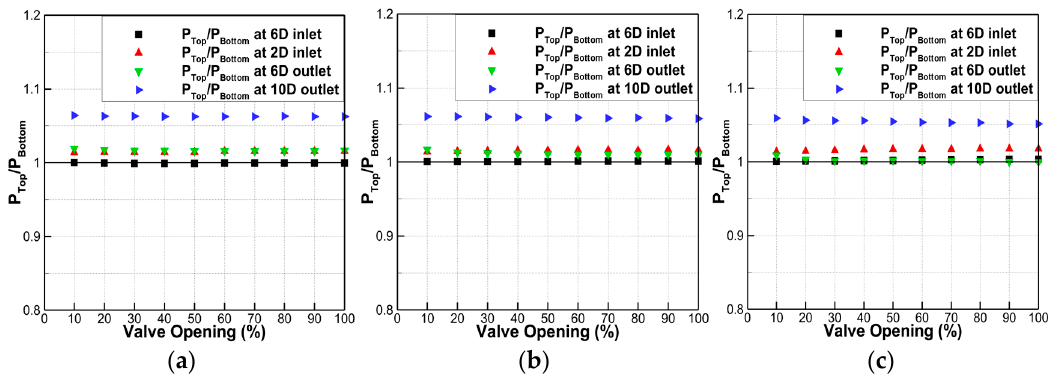
Figure 8. Comparison of pressure at the top to the bottom of the pipeline: ( a ) 1000 RPM; ( b ) 1500 RPM; ( c ) 2000 RPM.